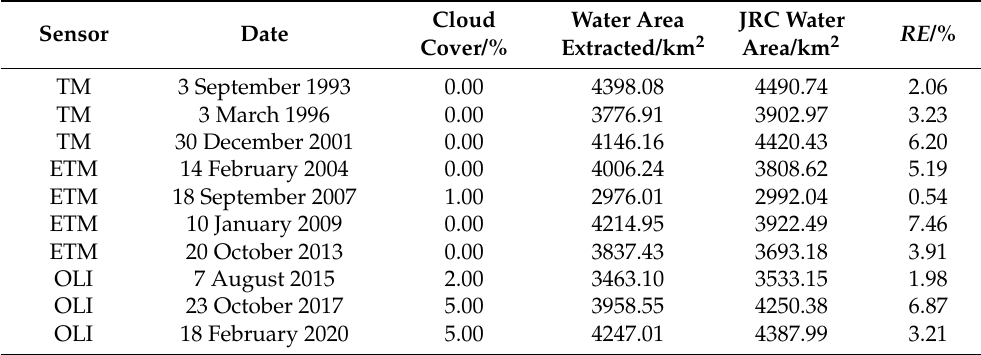
Table 1. Comparison between the surface water area extracted in this study and the JRC water datasets.